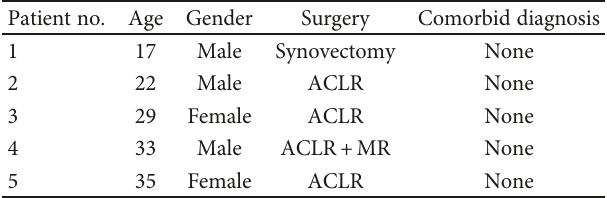
ACRL: anterior cruciate ligament reconstruction; MR: meniscal